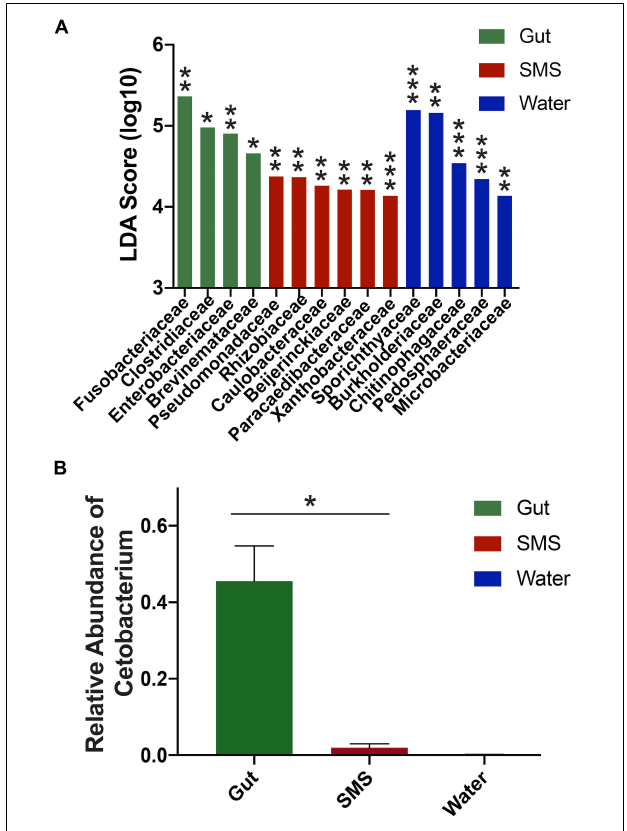
FIGURE 4 | Differences in abundances between SMS, Gut, and Water Communities. (A) LDA scores were calculated using LEfSe and indicate families associated with their respective community. Significance cutoff > 4.0 LDA score (log10). For full list of LDA and p -values, refer to